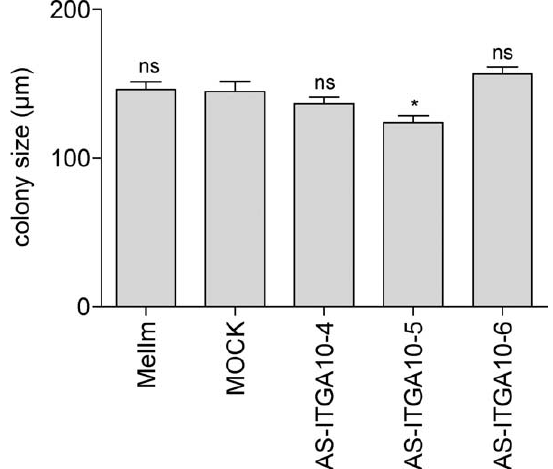
Fig. 4. Generation of melanoma cells with reduced expression of integrin alpha10. The cell line Mel Im was stably transfected with an antisense expression plasmid for integrin alpha10 and cell clones with reduced expression were generated by selection. By real-time PCR downregulation of expression of integrin alpha10 in the clones 4, 5 and 6 was confirmed whereas expression comparable to the wild type cell line Mel Im was found in the mock transfected cell clones mock 1 and 2 (*: p < 0 . 05, ns: not significant).